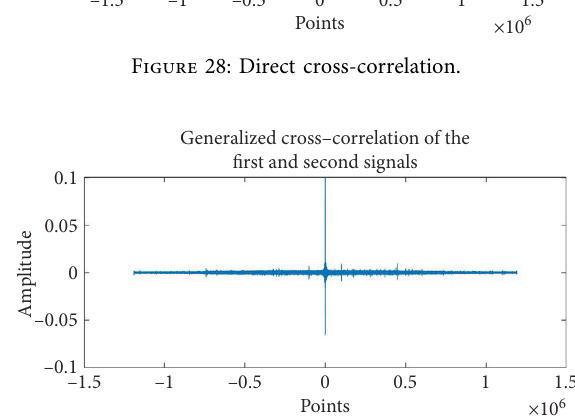
Figure 28: Direct